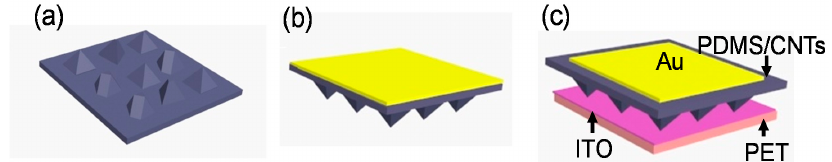
Figure 1. Schematic illustration of sensor fabrication. ( a ) Conductive layers with micro-structures are cured and peeled off from Si mold; ( b ) Au was deposited on the reverse side of conductive